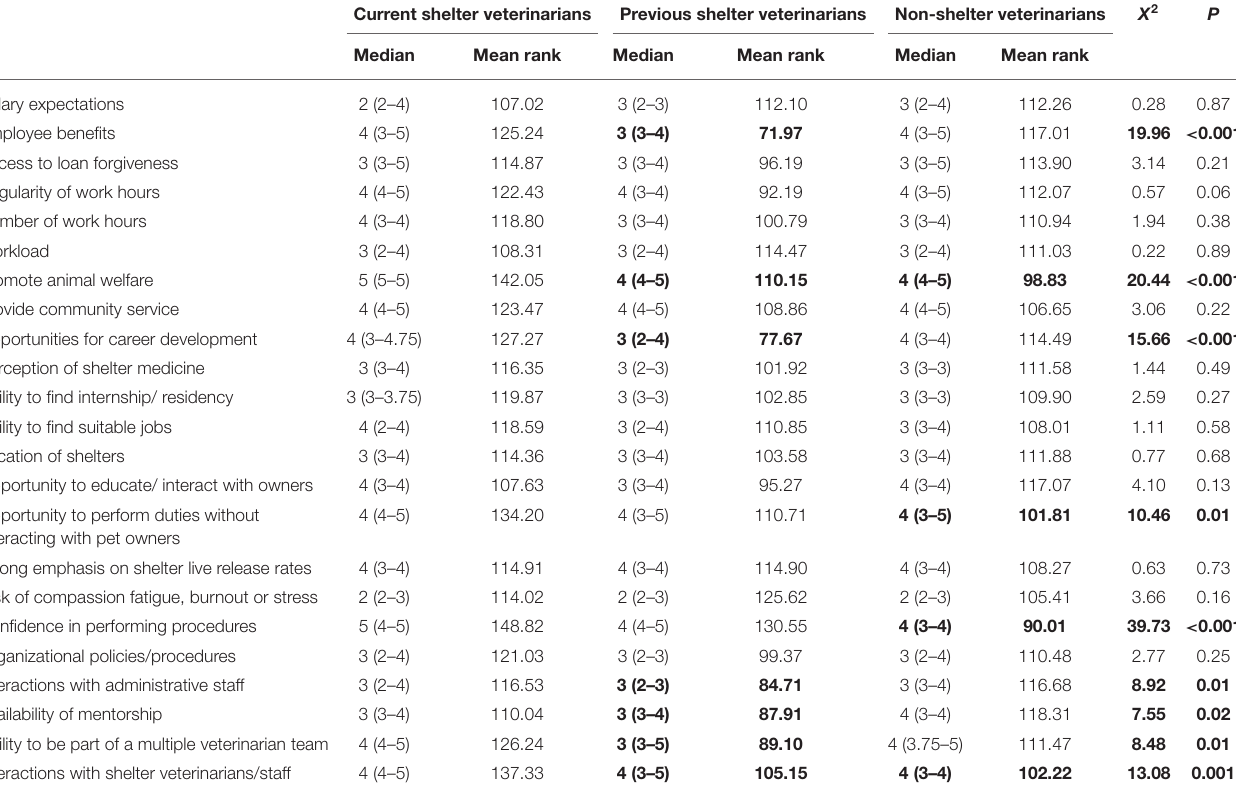
TABLE 4 | Kruskal-Wallis tests describing differences in the impact of characteristics of shelter medicine between current, previous, and non-shelter veterinarians.